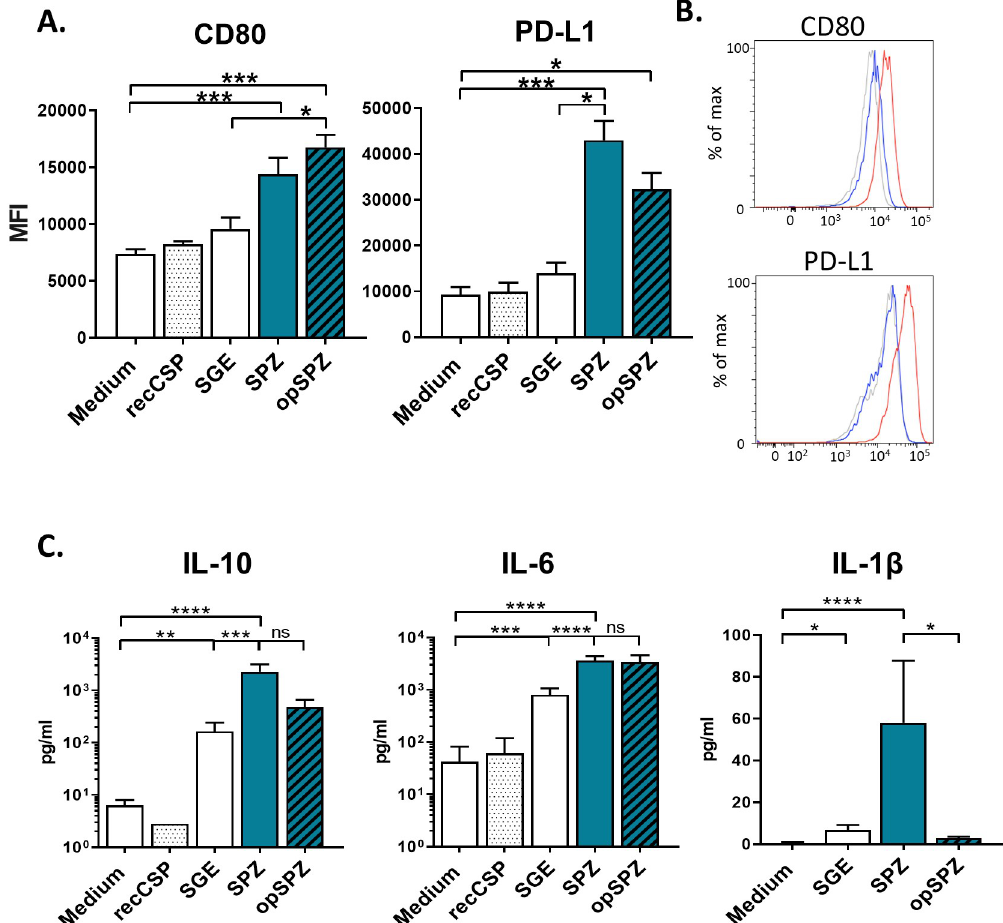
Fig 4. MoM ϕ responses to (opsonized) Pf SPZ. A . SPZ and opSPZ upregulate activation marker CD80 as well as regulatory marker PD-L1. Analysis using one way ANOVA. N = 9, at least 20 donors. B . Representative histograms of CD80 and PD-L1 surface marker expression. Medium stimulated MoM ϕ s in grey, SGE stimulated MoM ϕ s in blue and SPZ stimulated MoM ϕ s in red. C . MoM ϕ s produce IL-10, IL-6 and IL1 β in response to (op)SPZ stimulation. Analysis using one way ANOVA on log transformed data. � : P = < 0.05, �� : P = < 0.005, ��� : P = < 0.0005 and ���� : P = < 0.0001, ns = not significant. IL-10: N = 8, 25 donors; IL-6: N = 5, 17 donors; IL1 β : N = 3, 7